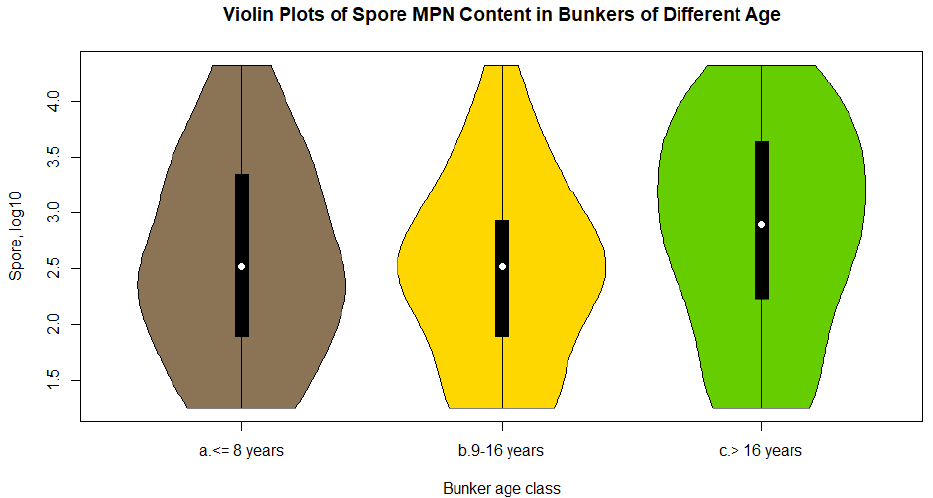
Figure 6. Distribution of anaerobic spore-forming bacteria spores (MPN, log 10 n /g) for the three age classes of bunker silos sampled within the study.